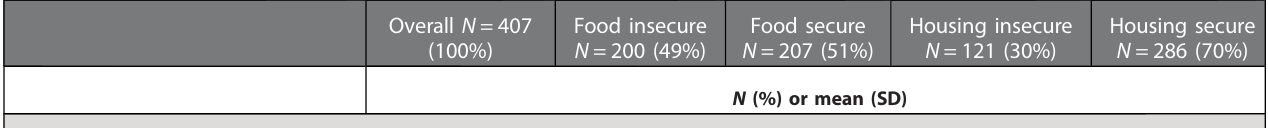
TABLE 1 Sample characteristics in the Clinic and Community Approaches to Healthy Weight trial by food and housing security status ( N